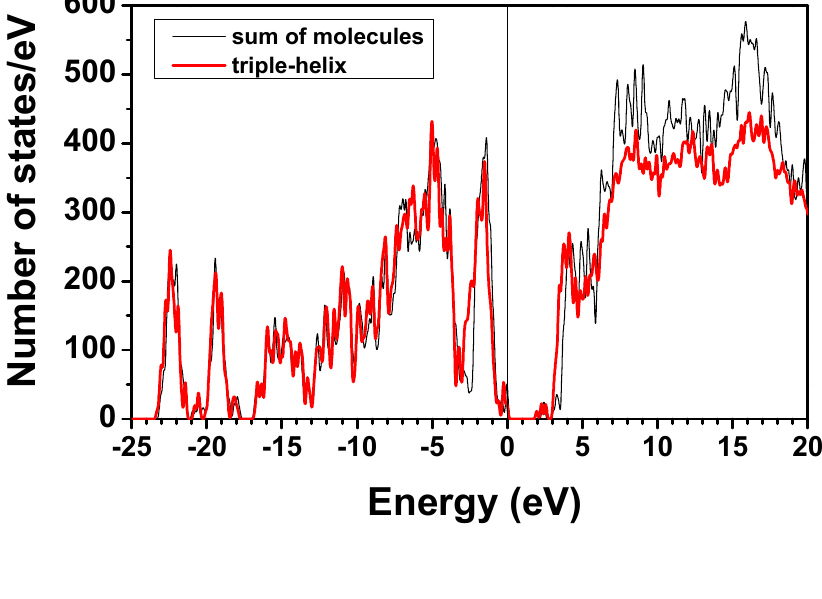
Figure 11. (Color on-line) Comparison of total density of states for triple-helix and the sum of three individual molecules calculated using the